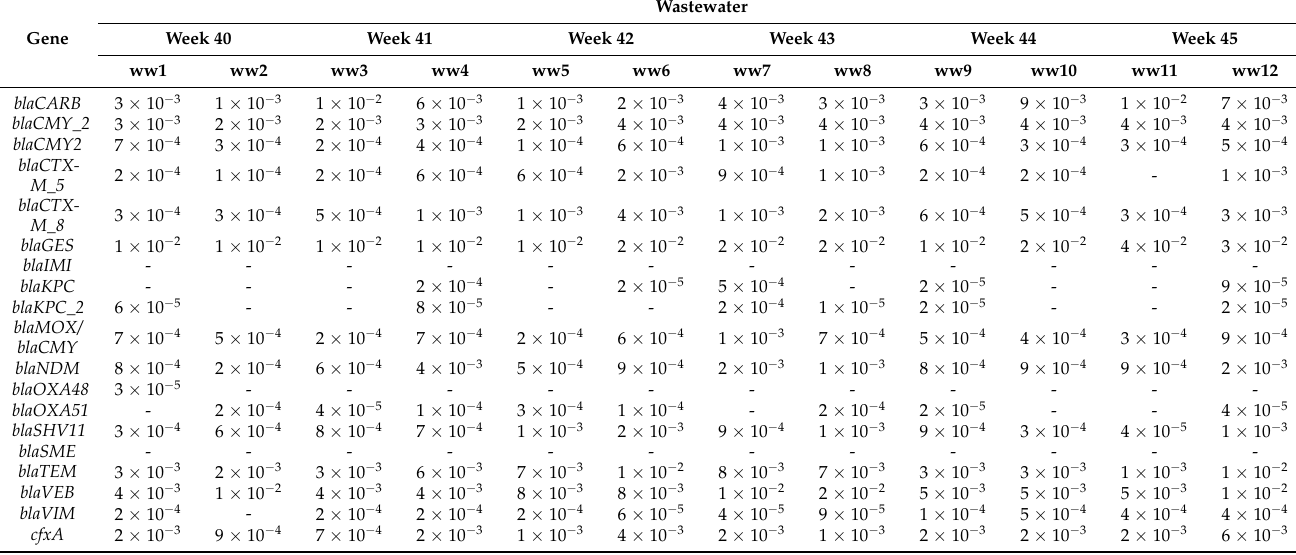
Table 1. Gene abundance of beta lactamase resistance genes relative to 16S rRNA in hospital wastew- ater samples and pathogens (copies/16s rRNA gene